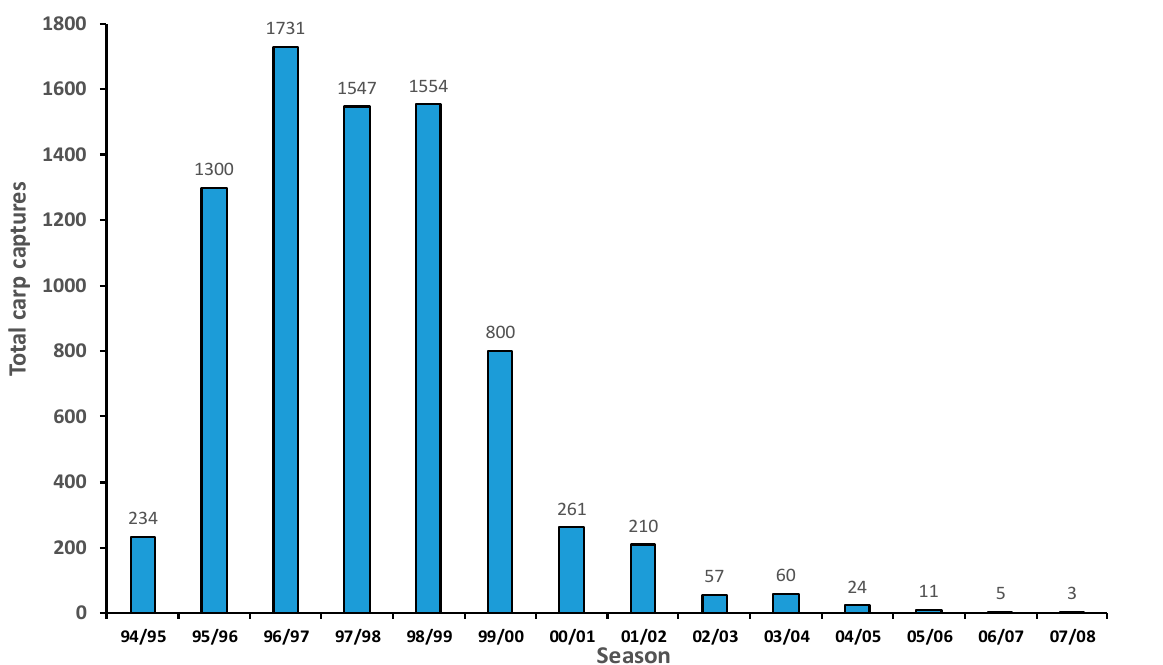
Figure 5. The last carp caught from Lake Crescent.